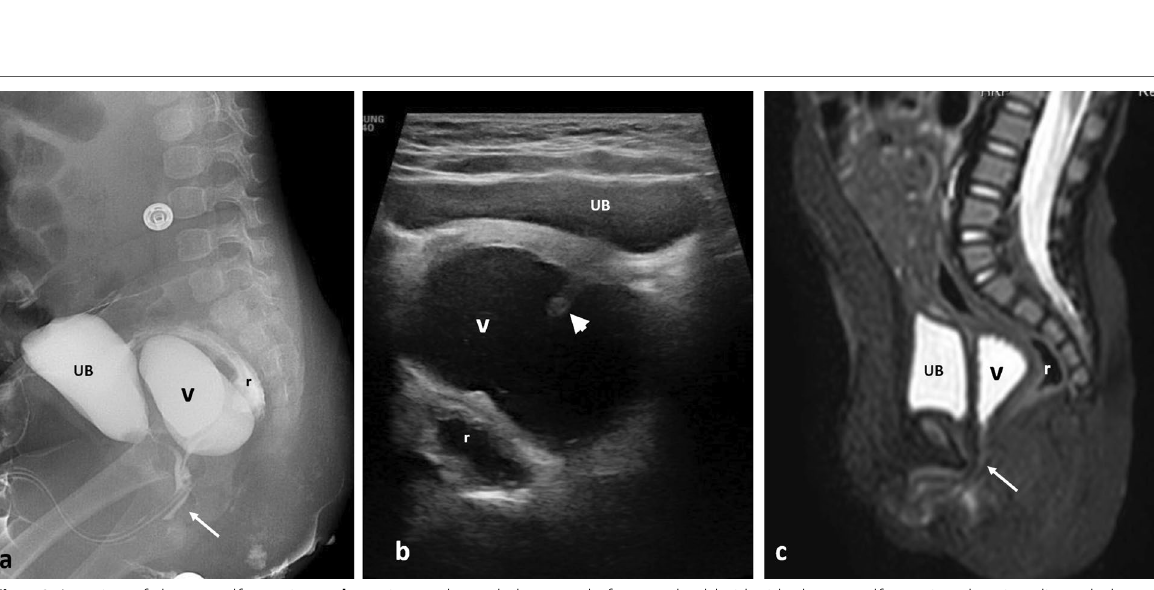
Fig. 18 Imaging of cloaca malformation. a , b genitography and ultrasound of 7-month-old girl with cloaca malformation showing distended vagina (asterisk) with incomplete vaginal septum (short arrow) with a long cloaca channel (long arrow). c Sagittal STIR MRI of 9-month-old girl with cloaca showing confluence of the rectum, distended vagina and bladder into a common cloaca channel (long arrow). r rectum, v vagina, UB urinary